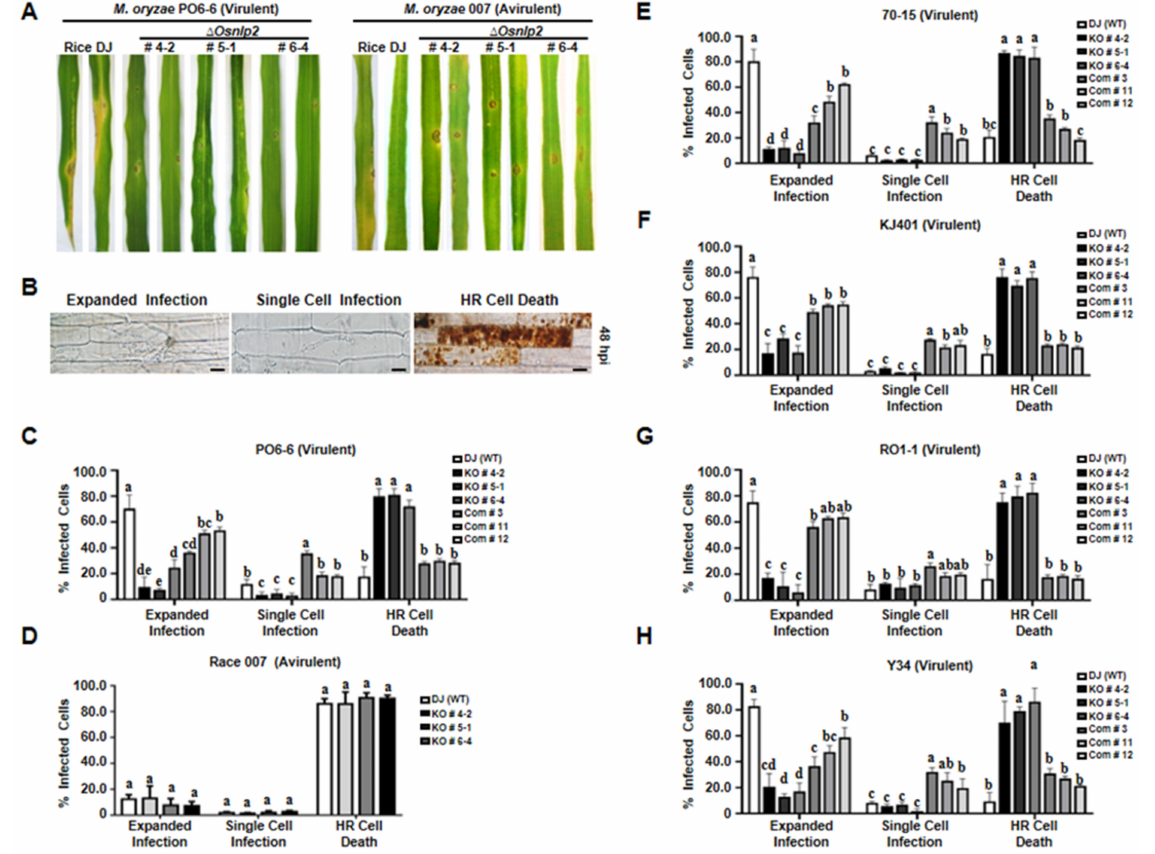
Figure 2. Infection phenotypes of ∆ Osnlp2 mutant lines after inoculation with different Magnaporthe oryzae strains. ( A ). Disease symptoms on leaves of rice DJ and ∆ Osnlp2 mutant lines at 5 days after inoculation with M. oryzae . M. oryzae conidial suspensions (1.0 × 10 5 conidia mL − 1 ) were sprayed on leaves of 3-week-old plants. ( B ). Infection types in epidermal cells of rice leaf sheaths at 48 hpi after M. oryzae inoculation. Thin epidermal layers of inoculated rice leaf sheaths were observed under a microscope (Zeiss equipped with Axioplan 2). hpi, hours post inoculation. Scale bars = 10 µ m. ( C – H ). Quantification of infection types in epidermal cells of rice leaf sheaths at 48 hpi after different M. oryzae inoculations. M. oryzae strains PO6-6, 007, KJ401, Y34, RO1-1, and 70-15 were used in the pathogenicity test. The cell numbers of different infection types were counted at 48 hpi using a light microscope. The data are means ± standard deviation (SD) of cell numbers of different infection types in leaf sheaths from different rice plants ( n = 4). Different letters above the bars indicate significantly different means as determined by the least significant difference (LSD) test ( p <